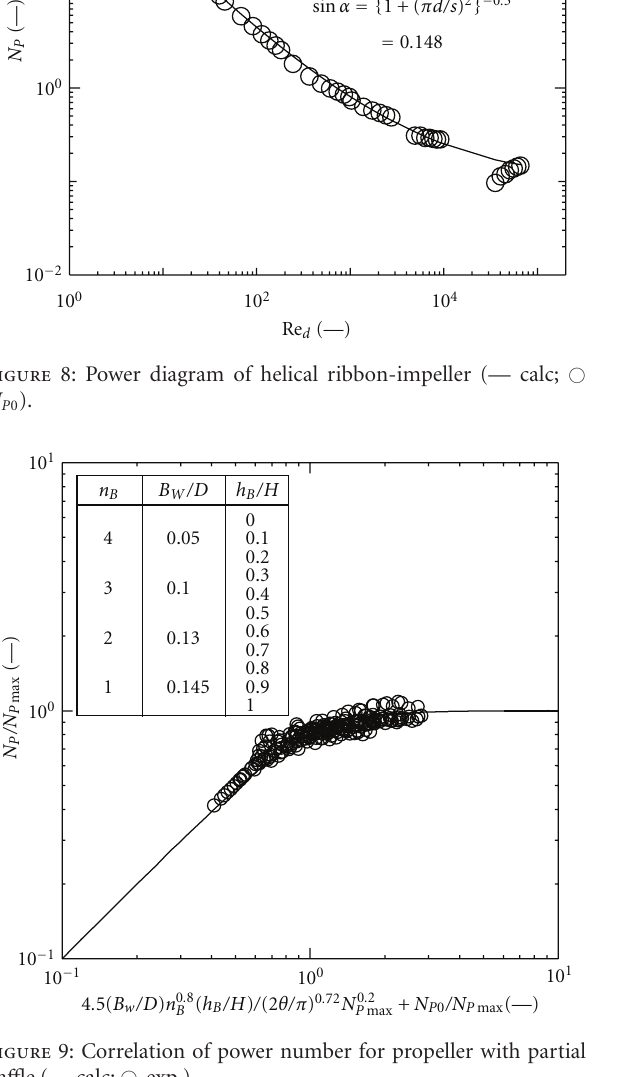
Figure 9: Correlation of power number for propeller with partial ba ffl e (— calc; (cid:2) exp.).